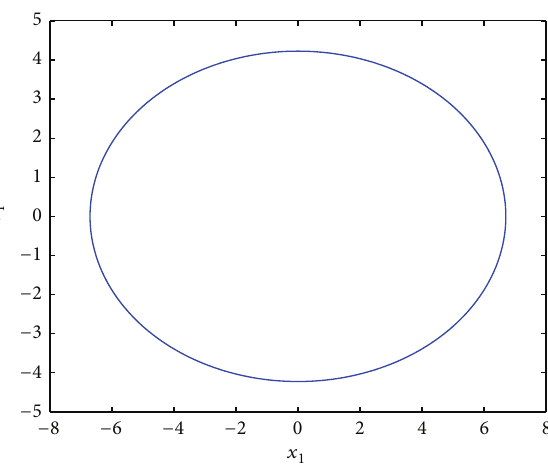
orbit located at the right-hand side of the grazing bifurcation point of the original system. When 𝑏 = 6.6 , Figure 10 indicates that there exists the chaotic motion located at the left-hand side of the grazing bifurcation point of the original